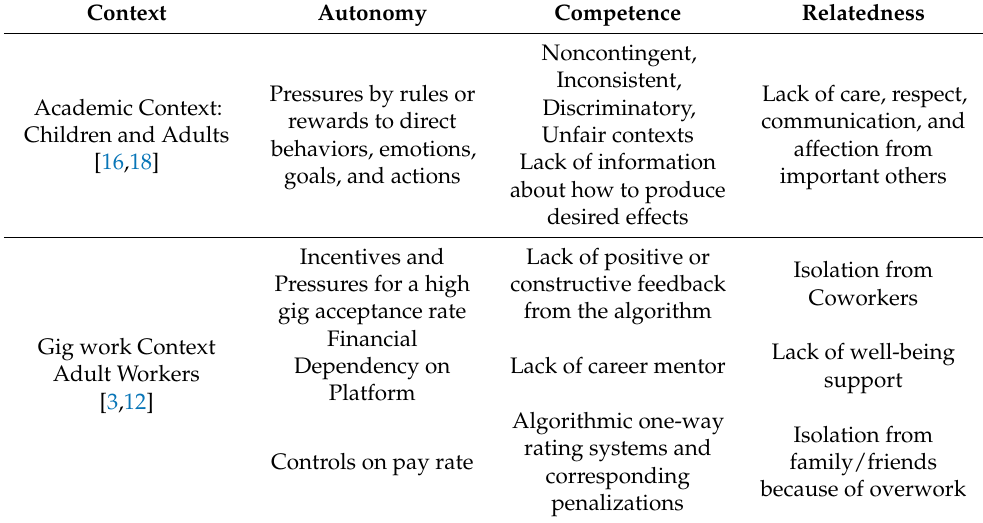
Table 1. Predictors of frustration of basic psychological needs in academic and gig-work